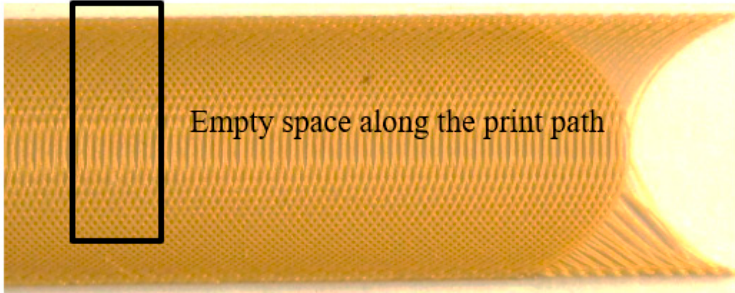
Figure 7. Polymeric printed sample in curved paths with a start and end angle of 70° and center angle of 0°.